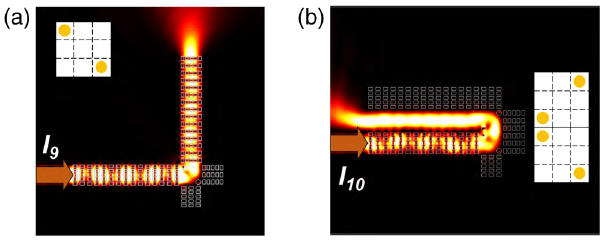
FIG. 10. Structural optimization in corner supercells to improve the transmission efficiency in bending circuits. (a),(b) The simulated intensity distributions under independent excitation from the input ports I 9 and I 10 . The insets are the enlarged views of the structure at the corner supercells. These yellow rods have radius r ¼ 2 mm and permittivity ε ¼ 12 . The other parameters are the same as in Figs. 4 and 5. The transmission efficiency of 90° bend (a) increases from 83% to 93%, and the transmission efficiency of 180° bend (b) increases from 64% to